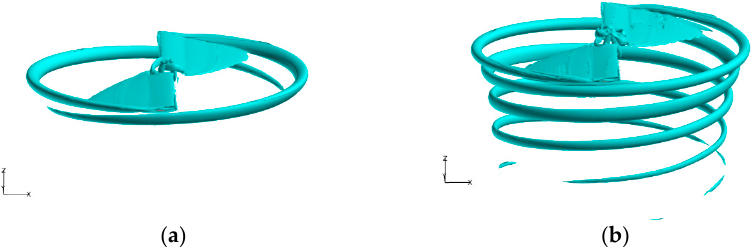
Figure 6. Comparison of primary rotation flow field in vorticity iso-surfaces. ( a ) MUSCL—Roe ( b ) WENO—Roe.